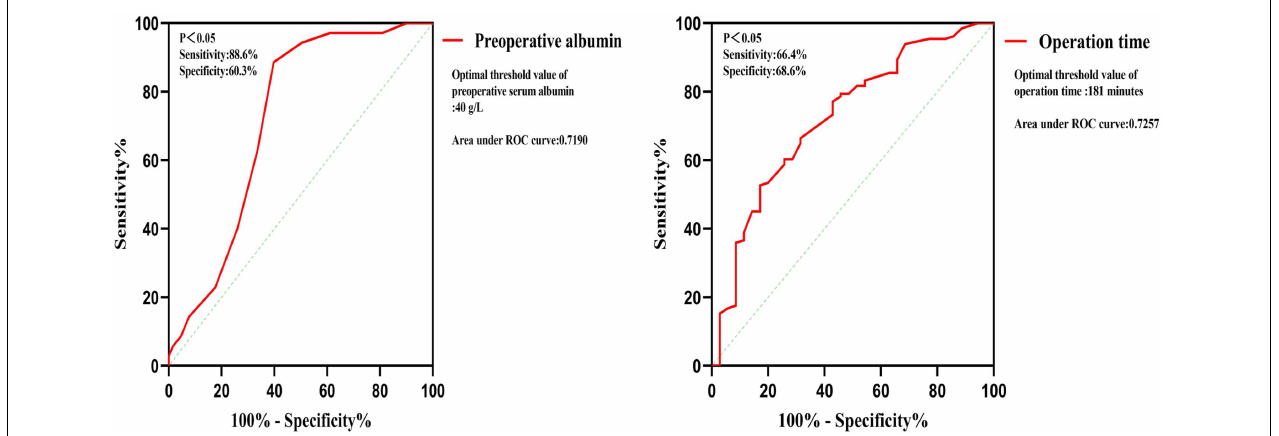
FIGURE 2 | Receiver operating characteristic (ROC) curve of preoperative albumin and operation time.